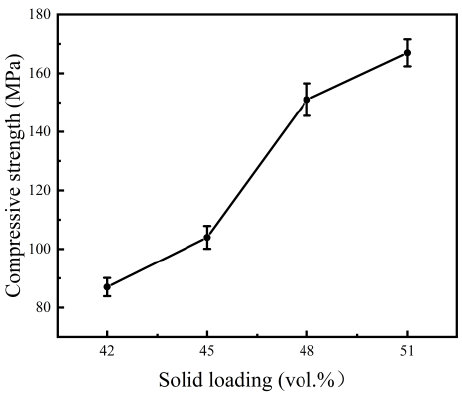
Figure 12. The compressive strengths of sintered specimens with various solid loading rates.